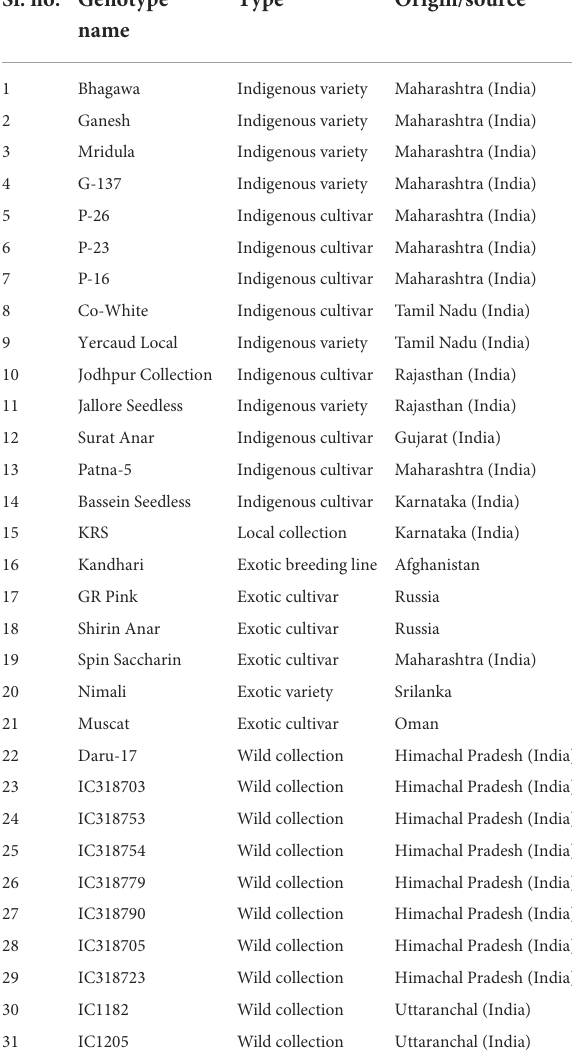
TABLE 1 The details of 31 different genotypes of pomegranate used in this